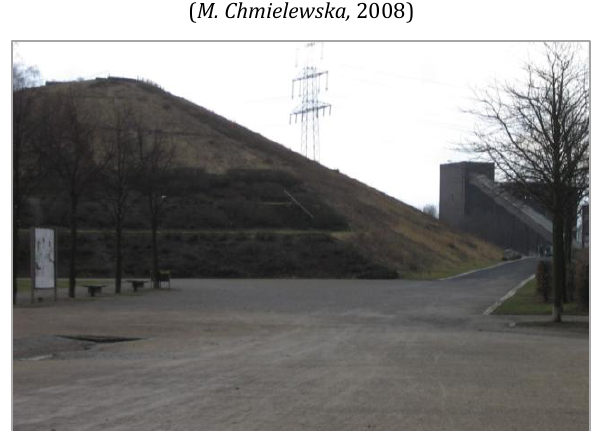
Fig. 6. Tetraeder on Bottrop